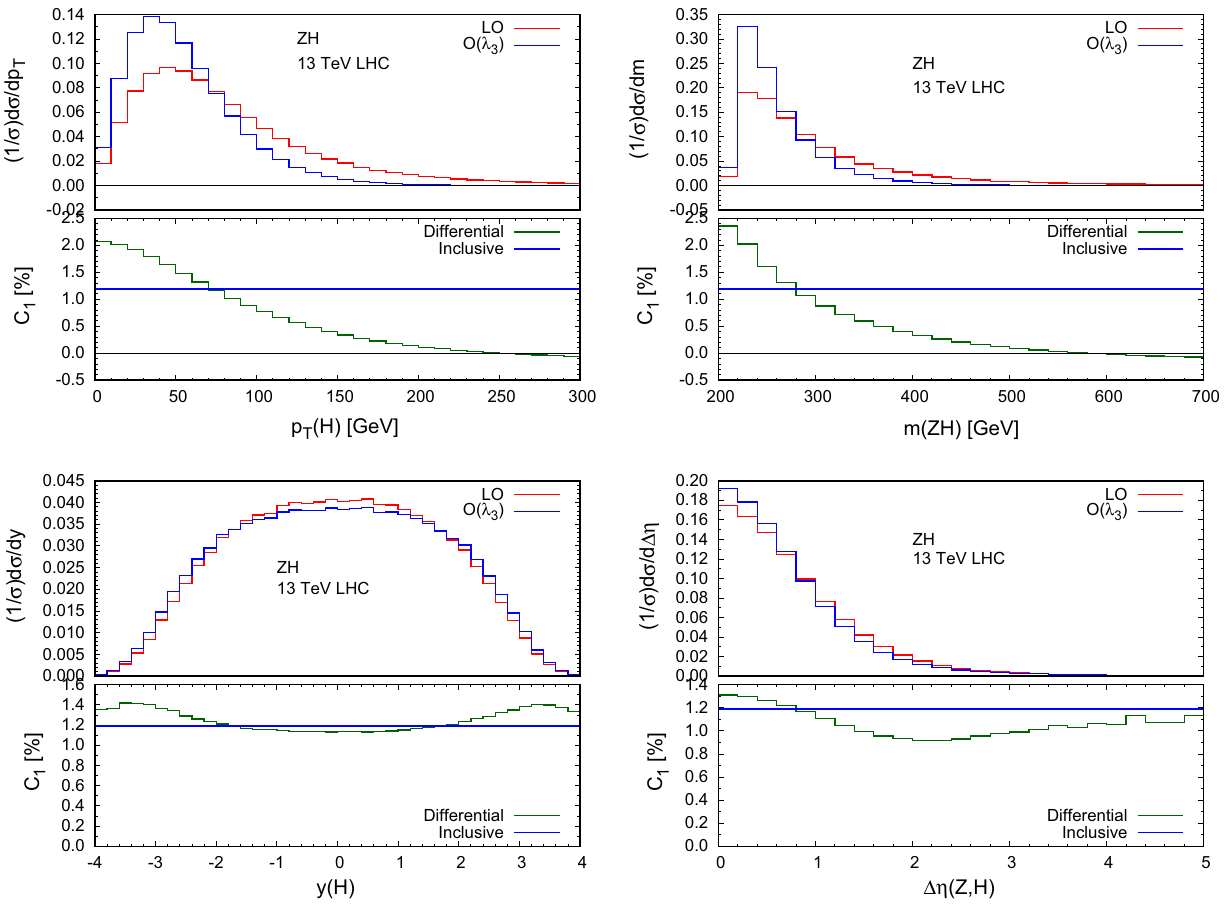
Fig. 3 Effect of O (λ 3 ) correction in Z H at 13 TeV LHC. Upper panel: normalized distributions at LO (red) and at O (λ 3 ) (blue). Lower panel: C 1 at the differential (green) and inclusive (blue) level pseudo-rapidity of the V and H bosons (cid:11)η( V , H ) . The lat- ter is particularly interesting because C 1 is enhanced